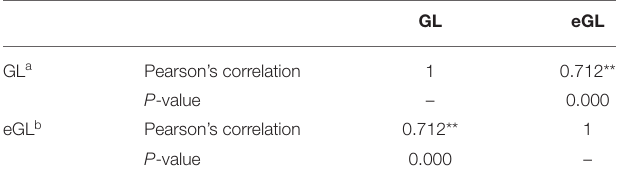
TABLE 3 | Relationships between means of GL and eGL for available processed